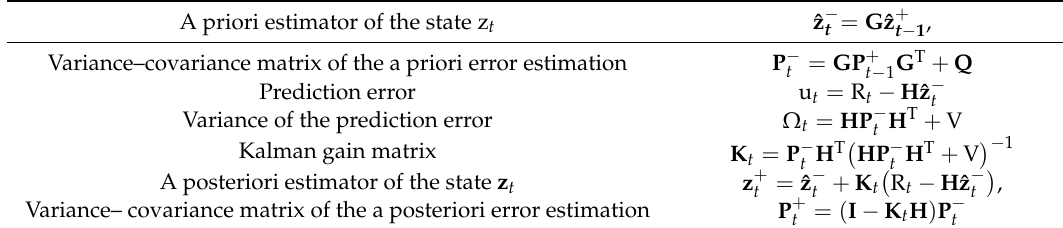
Table 1. Equations of the discrete Kalman